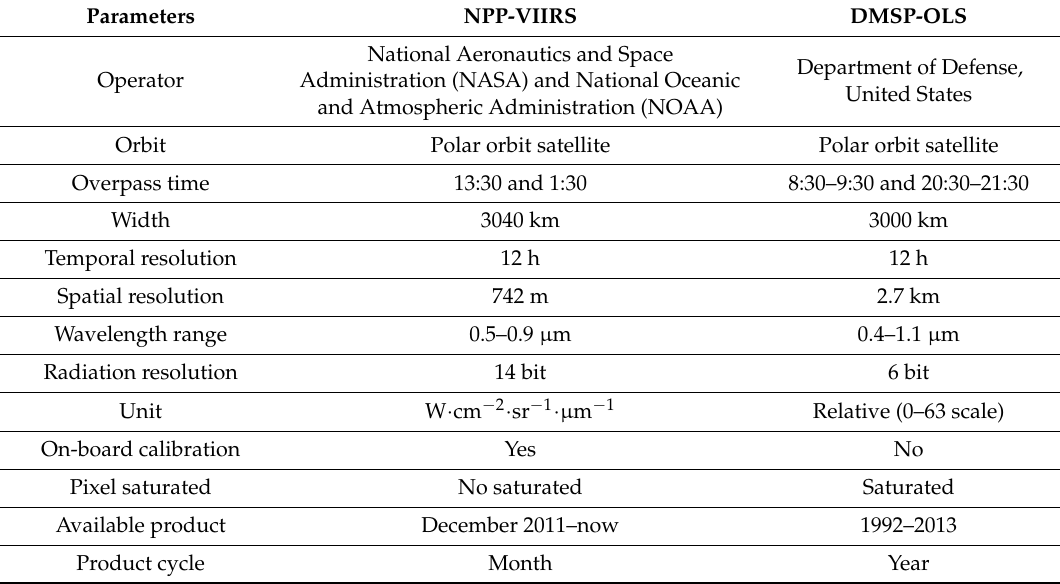
Table 1. The parameters of NPP-VIIRS and DMSP-OLS